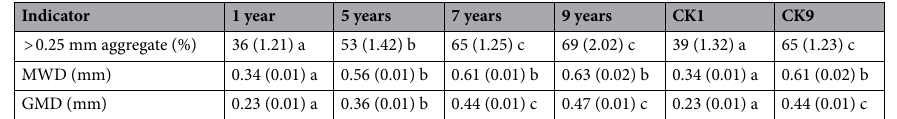
Table 3. Effects of organic amendments on the structural stability in reconstructed mine substrates (RMS). Parentheses show standard deviations. Dissimilar letters indicate significant differences, whereas similar letters indicate no significant difference among the treatments in the same column at p < 0.05.